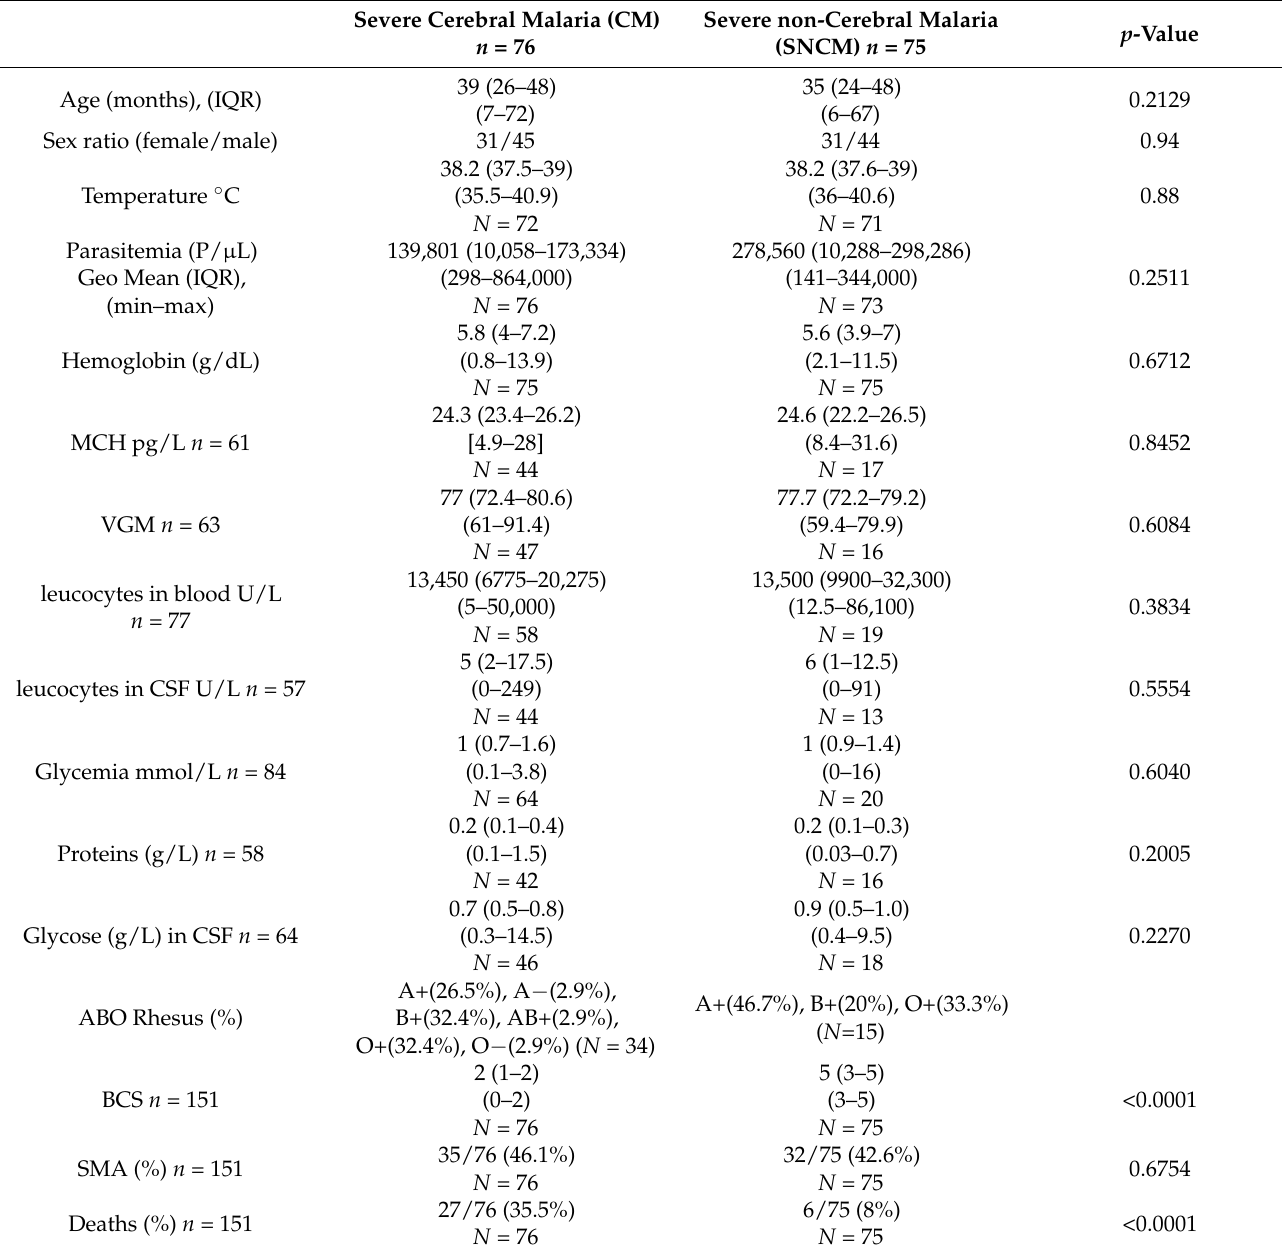
Table 1. Biological, clinical, and parasitological futures of the Beninese children enrolled in the study at admission to hospital. The non-parametric Mann–Whitney U test was used to compare the clinical